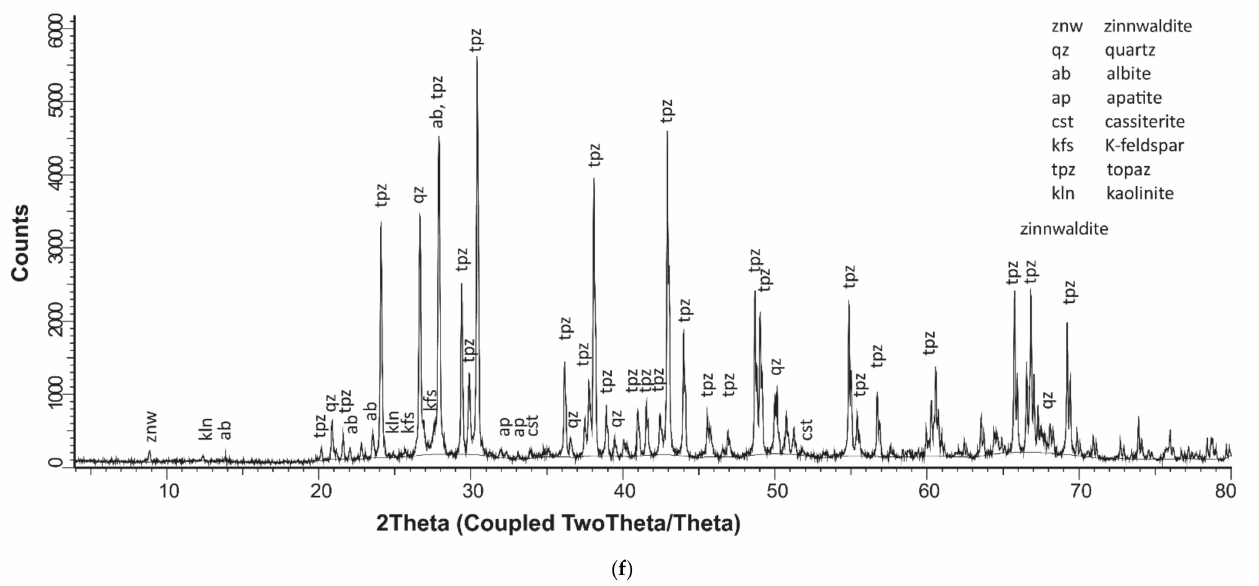
Figure 4. XRD patterns of: ( a ) wet shaking table followed with magnetic separation of light fraction (WST-LF), ( b ) ap. conc.,